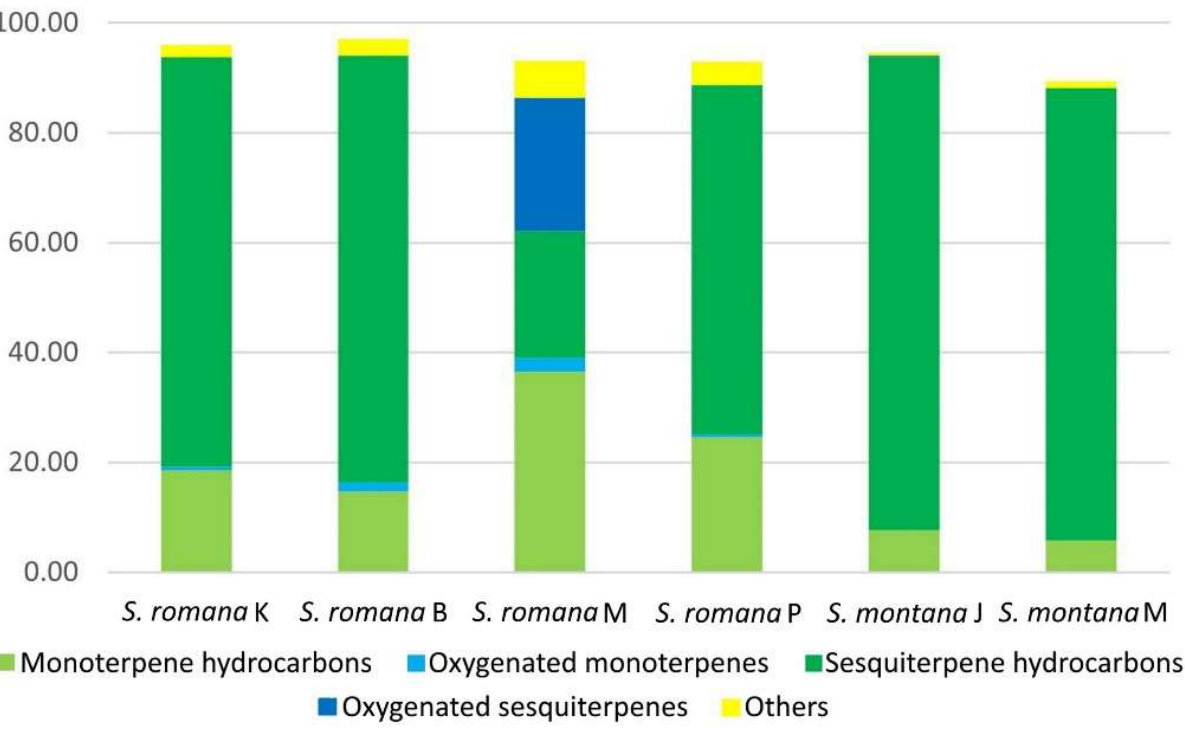
Figure 2. Average relative percentages of different classes of headspace volatile organic compounds obtained from various populations of S. romana and S. montana using PDMS/DVB fiber.